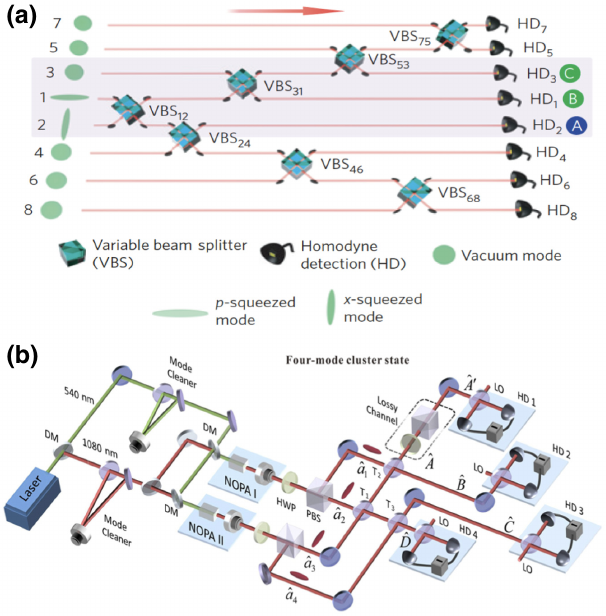
FIG. 2. (a) Schematic diagram of the experimental configura- tion of Armstrong et al. [15] to demonstrate multipartite steering in a programmable linear optics circuit. Independent qumodes are shaped to be multiplexed on the same beam. By program- matically changing the measurement basis, the scheme allows to emulate linear optical networks in real time. (b) Outline of the experiment of Deng et al. [44] to demonstrate the presence of constrains in the distribution of steering between four modes of a square cluster state imposed by the monogamy